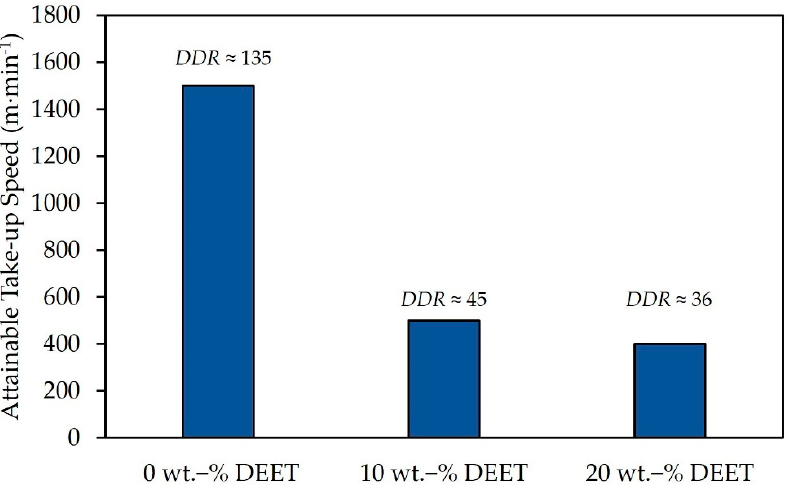
Figure 5. Attainable take-up speeds for melt-spun DEET-containing PDLLA monofilaments as a function of DEET content.